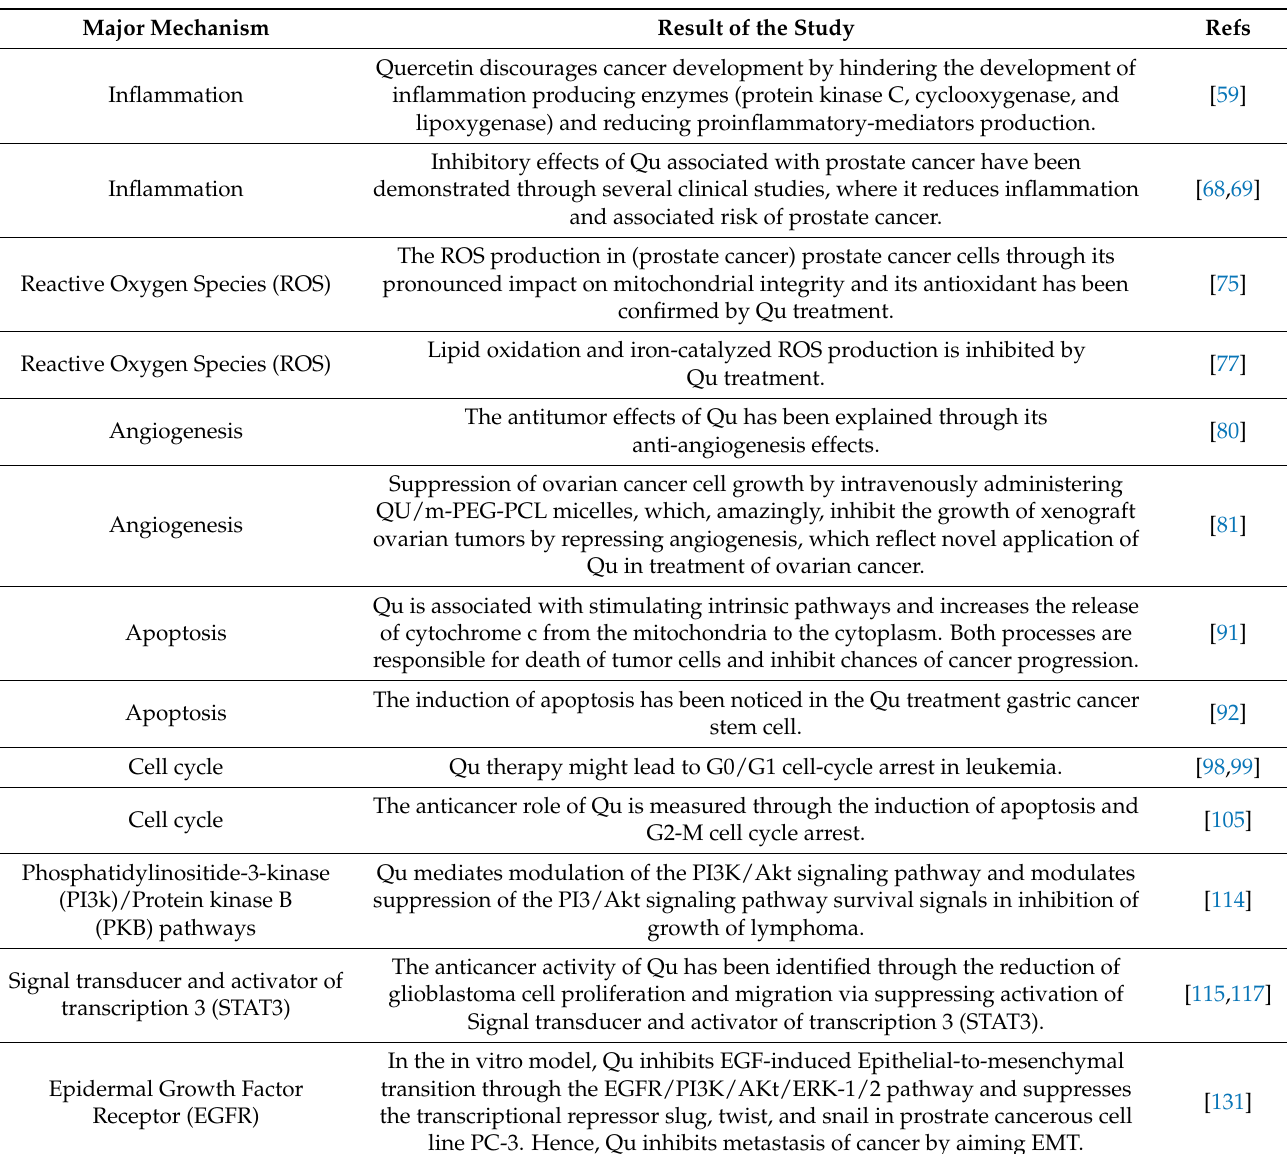
Table 1. Major mechanism of action of quercetin in cancer